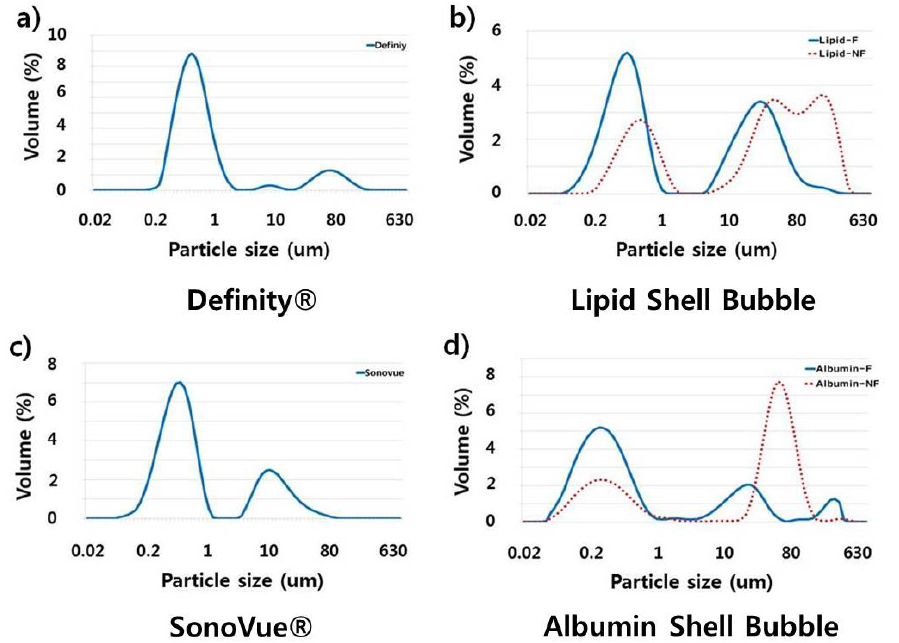
Figure 4. Size distributions of UCAs. The size distribution of UCAs was measured with a particle size analyzer (Mastersizer 2000, Malvern Instruments Ltd., UK) and plotted against volume. In this figure ‘NF’ indicated non-filtered data, and ‘F’ indicated filtered data, respectively. The results indicate that the synthesized UCAs have approximately five times more volume percent of microbubbles in the range of 10–100 μ m compared to that of commercial UCAs. If the synsthesized UCAs was filtered once, the volume percent of the larger bubble was reduced approximately four times.